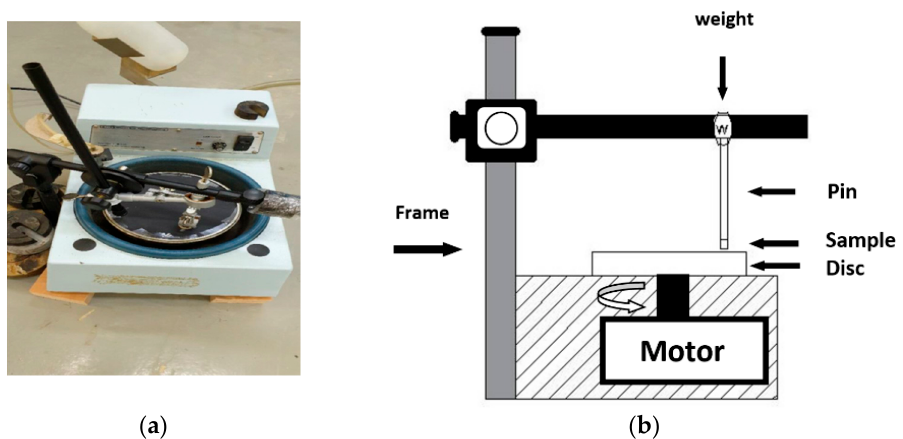
Figure 2. ( a ) Custom ‐ built tribometer used in this study; ( b ) diagrammatic sketch of the wear test setup.